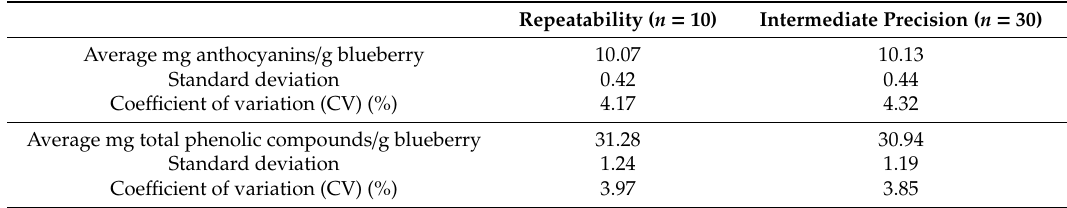
Table 4. Repeatability and intermediate precision study for anthocyanins and phenolic compounds recovery from blueberry